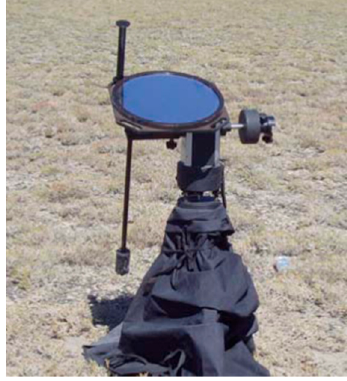
Figure 1. Reflective point source.